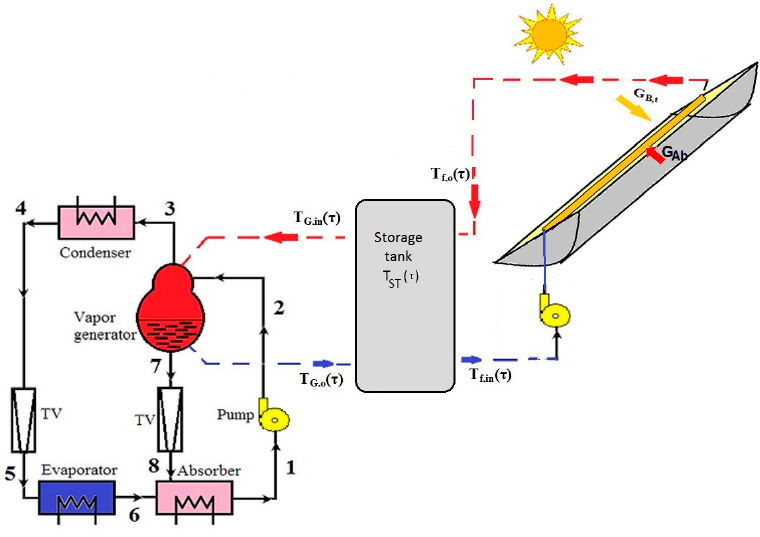
Figure 2. Simple effect one stage solar powered absorption cooling system.